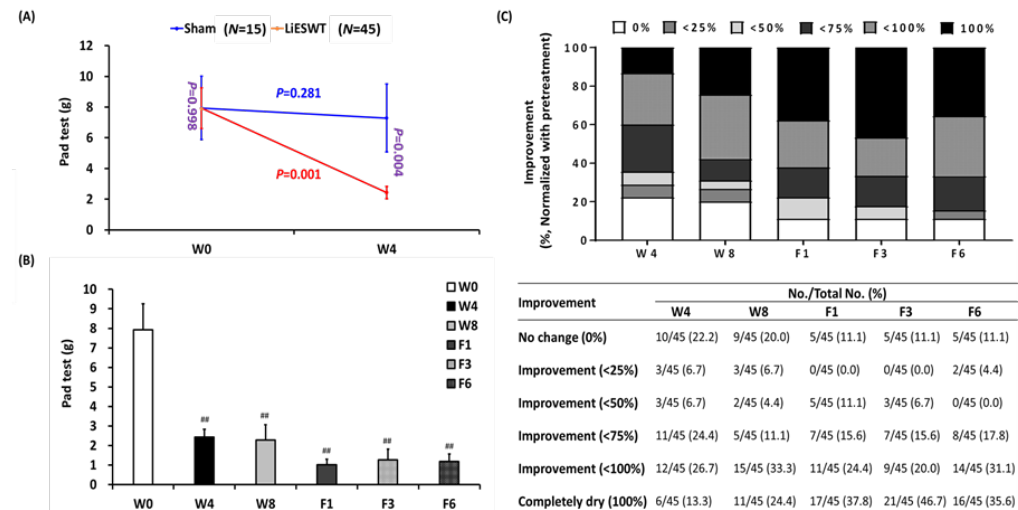
Figure 2. LiESWT decreased bladder leaks by pad test. ( A ) Pad test of the studied population for stress urinary incontinence (SUI) at 4 weeks (W4) in the sham-treated group ( N = 15) and the LiESWT-treated group ( N = 45). The blue font or red font denotes the p -value before and after 4 weeks of treatment in the sham group or in the LiESWT-treated group. The purple font indicates the p -value between the sham-treated group and the LiESWT-treated group at baseline (W0) and W4. Values are reported as means ± SE. ( B ) Pad test of the studied population for SUI at W4, 8 weeks (W8), 1-month follow-up (F1), 3-month follow-up (F3), and 6-month follow-up (F6). Values are reported as means ± SE. N = 45. ## p < 0.01 compared to the W0. ( C ) The percentage of improvement at W4, W8, F1, F3, and F6 after the LiESWT treatment, as normalized with the W0. N = 45.